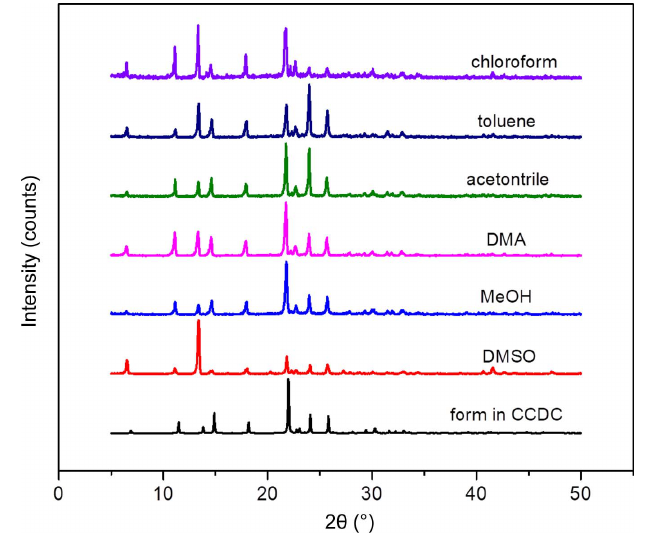
Figure 3 PXRD patterns of PHEN crystallized from different